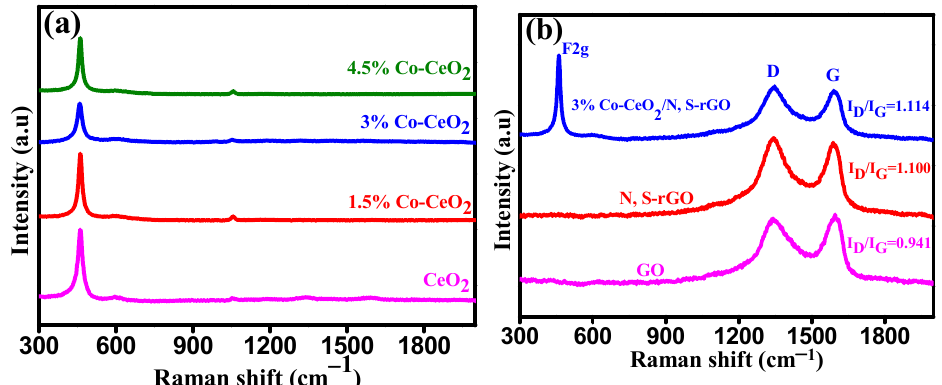
Figure 2. ( a ) Raman spectra of CeO 2 and Co-doped CeO 2 ; ( b ) Raman spectra of GO, N, S–rGO and 3% Co–CeO 2 /N, S–rGO.